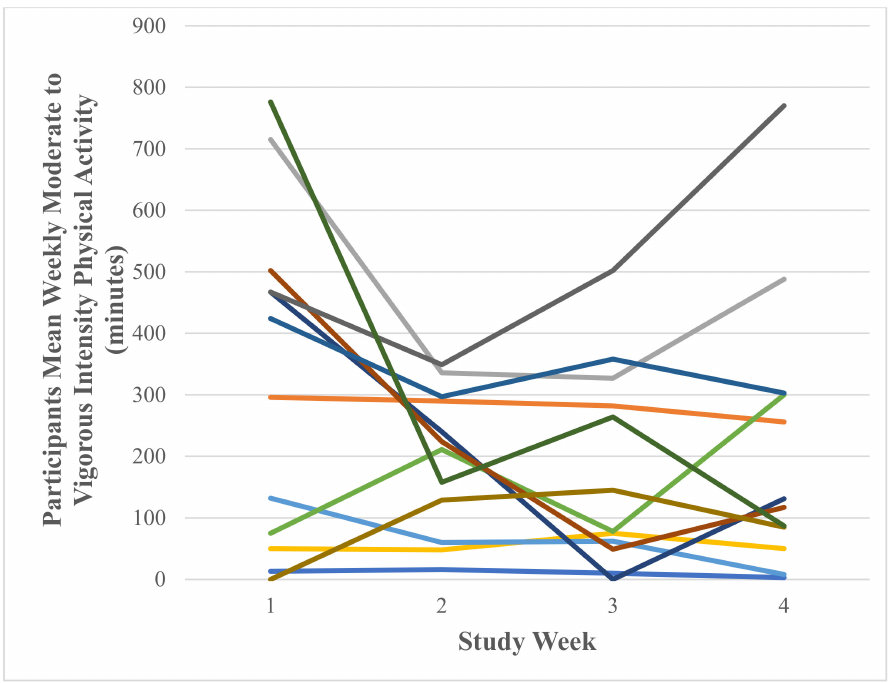
Figure 9. Individual participants’ mean weekly moderate- to vigorous-intensity physical activity (minutes) as recorded via the Fitbit Charge 4 activity tracker (each coloured line represents one of the 12